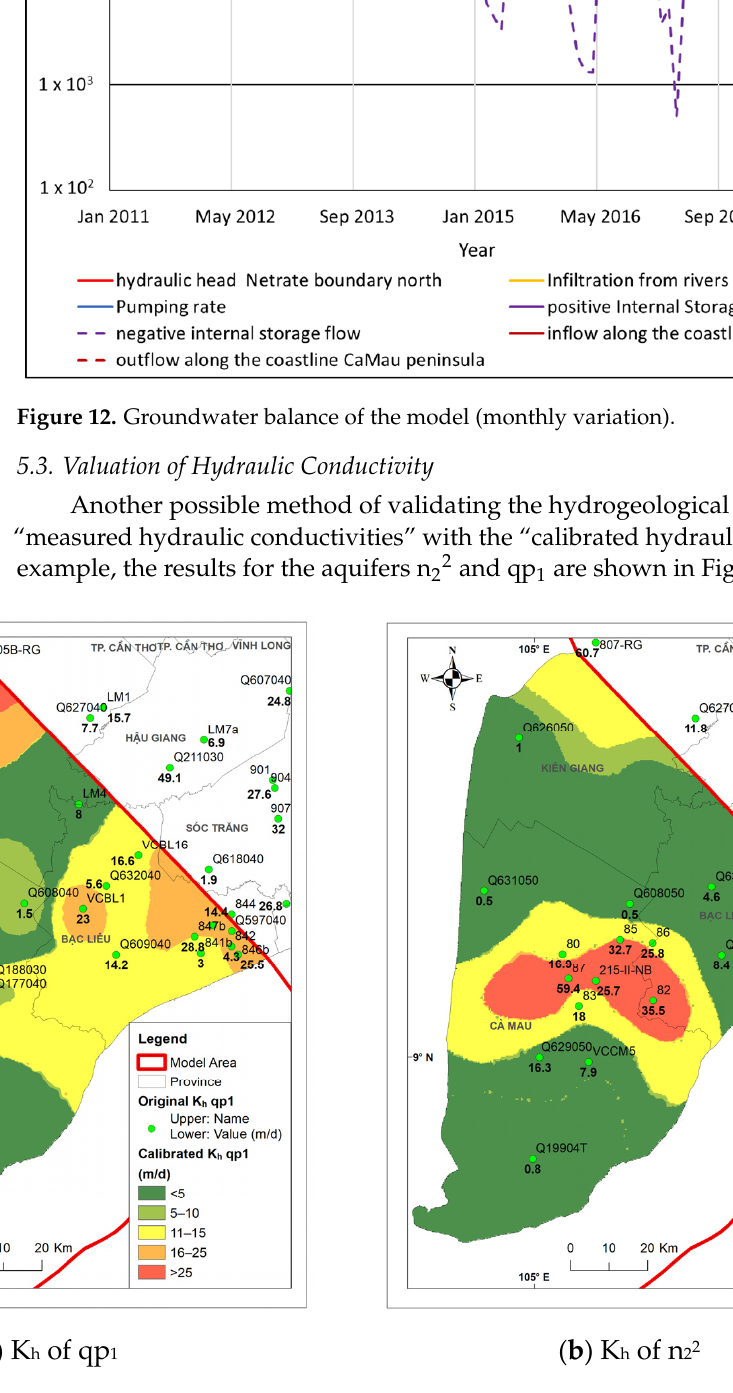
Figure 13. Calibrated K h for qp 1 and n 22 in comparison with K h from pumping test. For the aquifer qp1, the horizontal hydraulic conductivity (K h ) varies between 1.0 and 40 m/day. The highest K h is located in the northwest in Kien Giang province. The regions with K h higher than 25 m/day are located at the northern border. The regions with lower K h (green regions) stretch from the middle of the northern border along the west coast, including the southern part of the Ca Mau peninsula. The comparison of the measured K to the calibrated K shows an overall good correlation. For the aquifer n 22, the K h varies between 1.0 and 60 m/day. The highest K h is located in the surrounding area of Ca Mau city. Moreover, the regions with a K h higher than 37 m/day (red regions) are located here. The regions with lower K h (green regions) are located in the north and in the south part of Ca Mau peninsula. Additionally, in this aquifer, the comparison of the “measured K” to the calibrated K shows an overall good correlation. Shrestha et al. [32] and Nguyen et al. [7] developed groundwater models for the whole MKD and the Tay Island Region (Dong Thap province). The calibrated hydraulic conductivities used in these models are presented in Table 3 together with those of this study. The values for the K for groundwater layers qh, qp 3 , qp 2–3 , qp 1 , and n 13 of Shrestha et al. [32] are similar to those of the recent presentation. The K values from Nguyen et al. [7] are smaller for all aquifers because of limited hydrogeological data collected for the small study area. Both authors did not present a spatially distributed comparison of cali- brated and measured K.